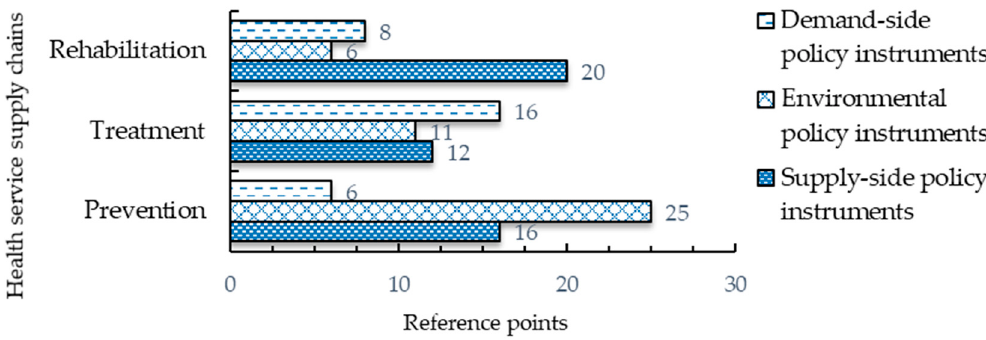
Figure 6. Frequency distribution of policy instruments in different stages of health service supply chains.